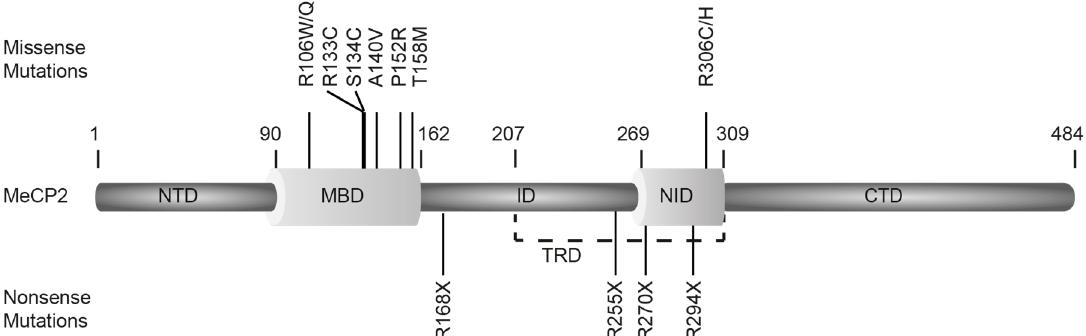
Figure 2. Diagram showing the high frequency mutation spectrum in Rett syndrome patients. A compendium of RTT mutations can be found in the online RettBASE. Missense mutations are shown above and nonsense mutations below the scheme showing the structure of MeCP2 (MeCP2 domains as in Figure 1). X means point mutation to stop codon, thus generating a truncated protein. Amino acids and substitutions are given according to the single-letter nomenclature. Mutation numbering according to human MeCP2 isoform starting in exon